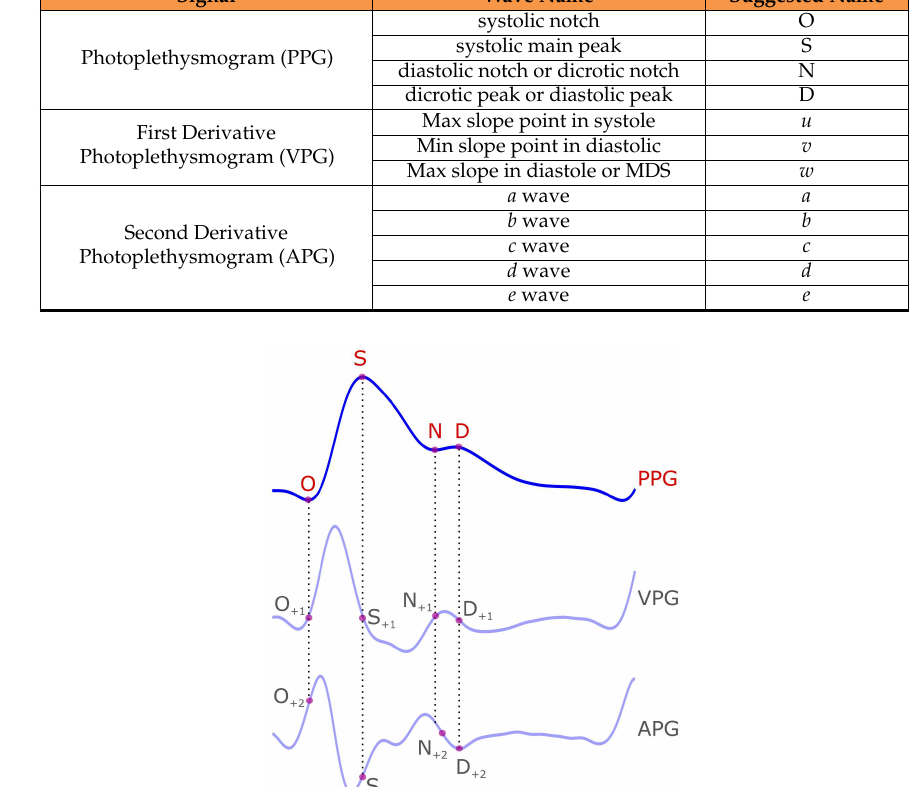
Figure 1. Demonstration of the photoplethysmogram (PPG) signal and its four waveforms (O(nset), S(ystolic), N(otch), and D(iastolic)). The four PPG waveforms are mapped on the velocity photoplethysmogram (VPG) and the acceleration photoplethysmogram (APG) signals. The subscript of +1 indicates the location of the PPG waveform on the first derivative of the PPG signal (i.e., VPG) while the +2 subscript indicates the location of the PPG waveform on the second derivative of the VPG signal (i.e., APG).